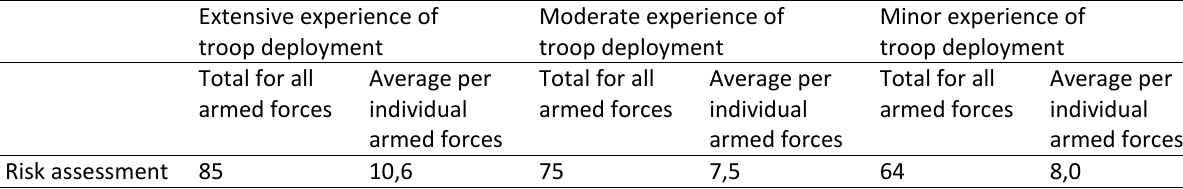
Table 1. Risks related to experiences of international deployments.